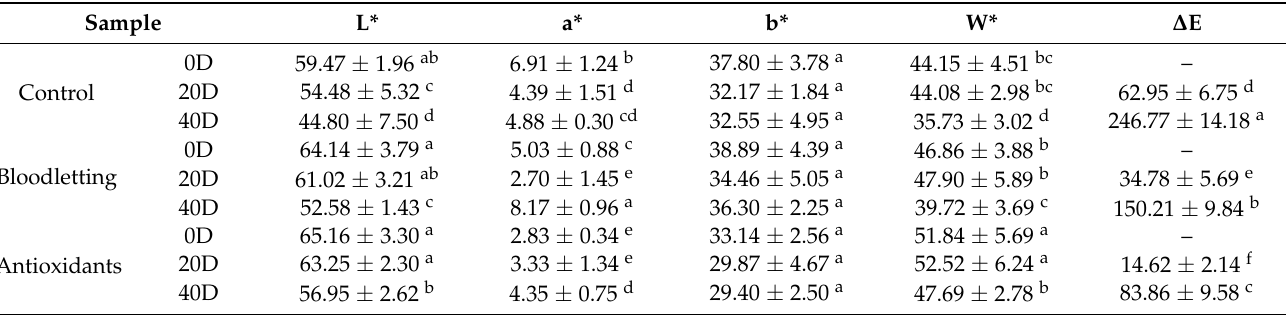
Figure 1. The appearance of abalone muscle during storage. Table 1. Changes in the color of abalone muscle during